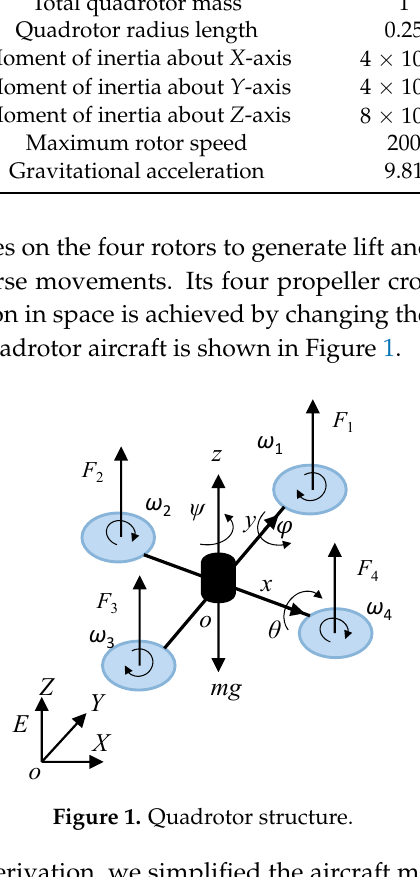
Table 1. Parameters of the quadrotor unmanned aerial vehicle (UAV). Parameter